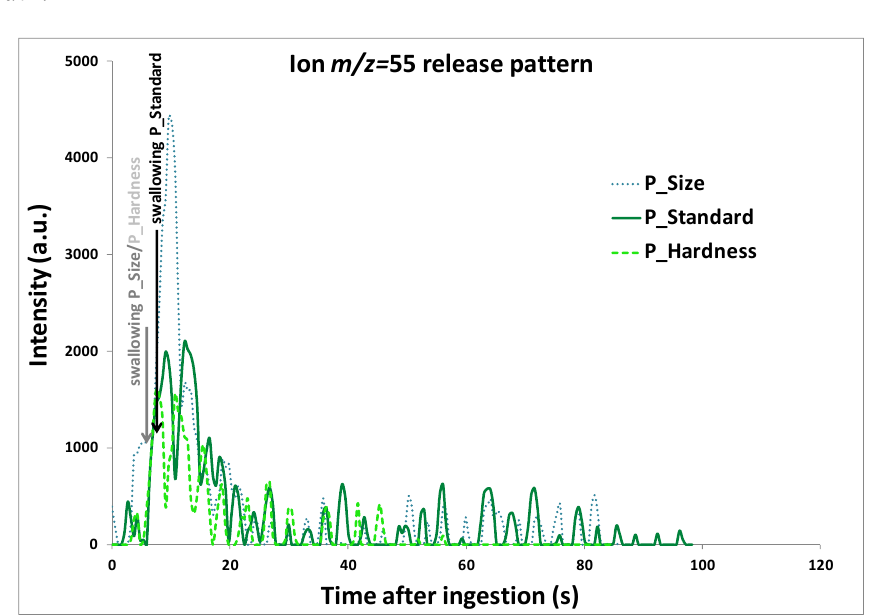
Figure 3. Release kinetics for ion m/z 55, corresponding mainly to cis-3-hexenyl butyrate, obtained by in vivo PTR-MS measurement with one panelist during the consumption of the three yogurts, P_Standard, P_Size and P_Hardness. The PTR-MS instrument drift tube was thermally controlled (60 °C) and operated with voltage and pressure set at 600.1 (±0.4) V and 1.9 (± 0.06) mbar, respectively. Time 0 corresponds to the time of product introduction in the mouth.